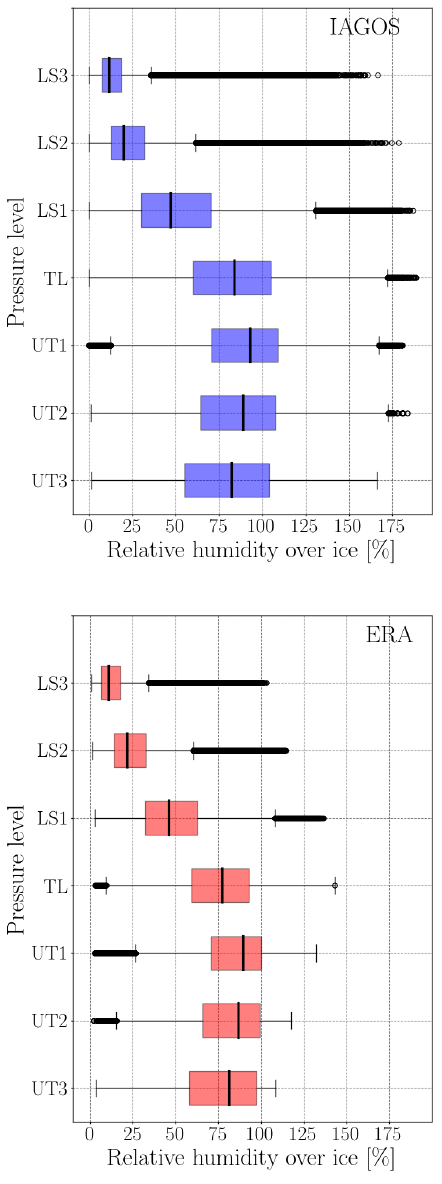
Figure 4. Vertical profile of relative humidity with respect to ice (RH i ) (%) for IAGOS (blue) and ERA